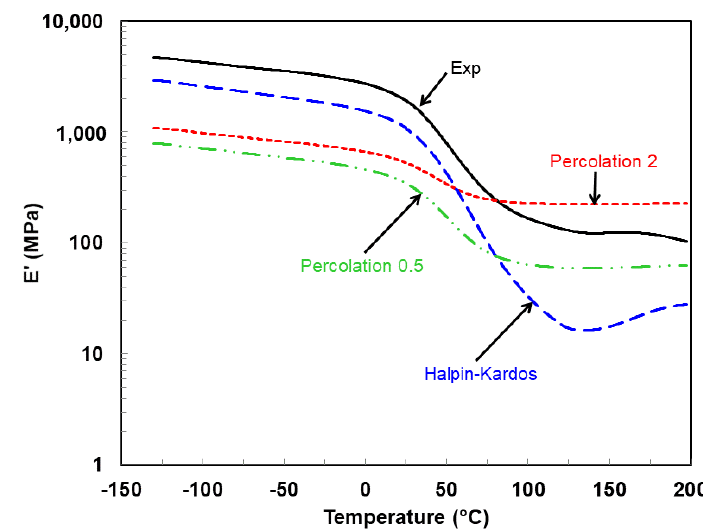
Figure 4. Storage modulus (E’) versus temperature for the lignopolyurethane composite reinforced with CNC. Comparison between the experimental data (Exp) and predicted data from the Halpin-Kardos model (Halpin-Kardos), and percolation approach using a modulus of 0.5 GPa (Percolation 0.5) or 2 GPa (Percolation 2) for the percolating CNC network (E R ).